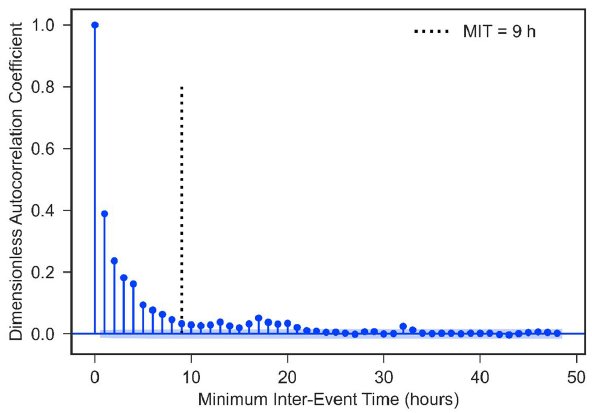
Figure 8. Autocorrelation of rain pulses.